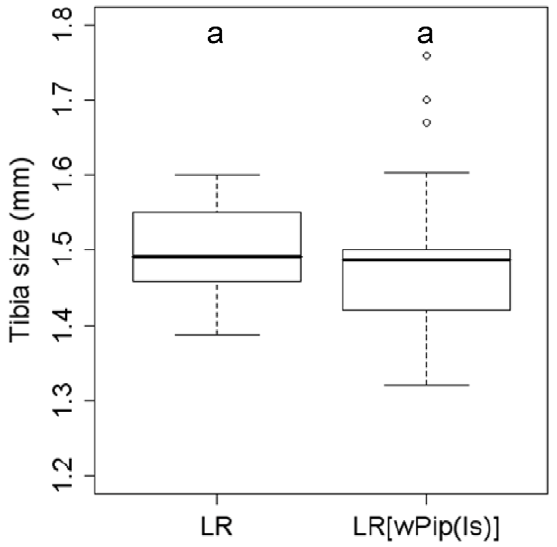
Figure 3. Tibia size of the LR and LR[ w Pip(Is)] males. Thirty individuals have been measured for each line. a represents statistical group (Wilcoxon two sided-test).